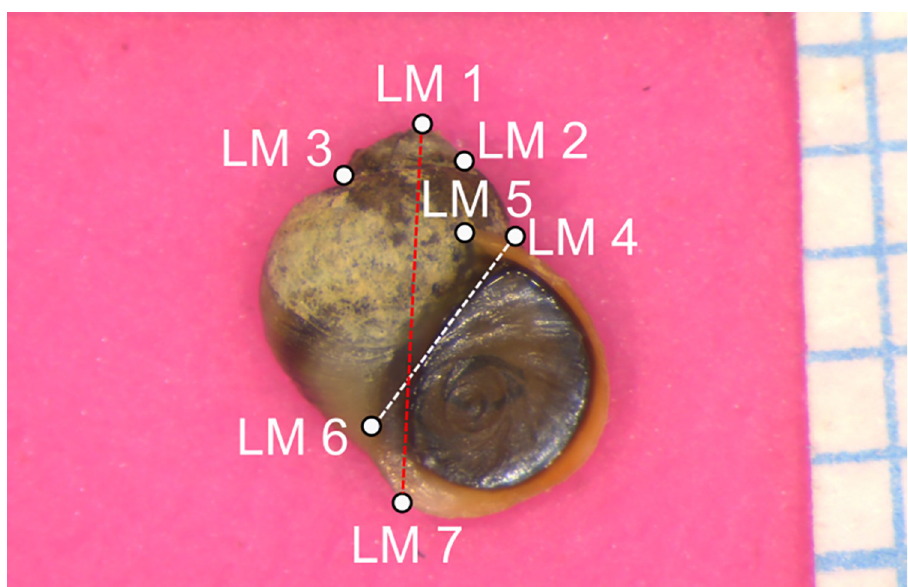
Fig 3. An example of a Littorina shell image and seven landmarks. LM1 is defined as the apex of the shell; LM2 is defined as the upper suture of the penultimate whorl (right); LM3 is defined as the upper suture of the penultimate whorl (left); LM5 is defined as the end of the suture; LM6 is defined as the point at the external edge of the lip and the line between LM4 and LM6 (white dotted line) is tangent to the operculum; LM7 is defined as the point at the bottom of the shell and the line between LM1 and LM7 (red dotted line) is tangent to the